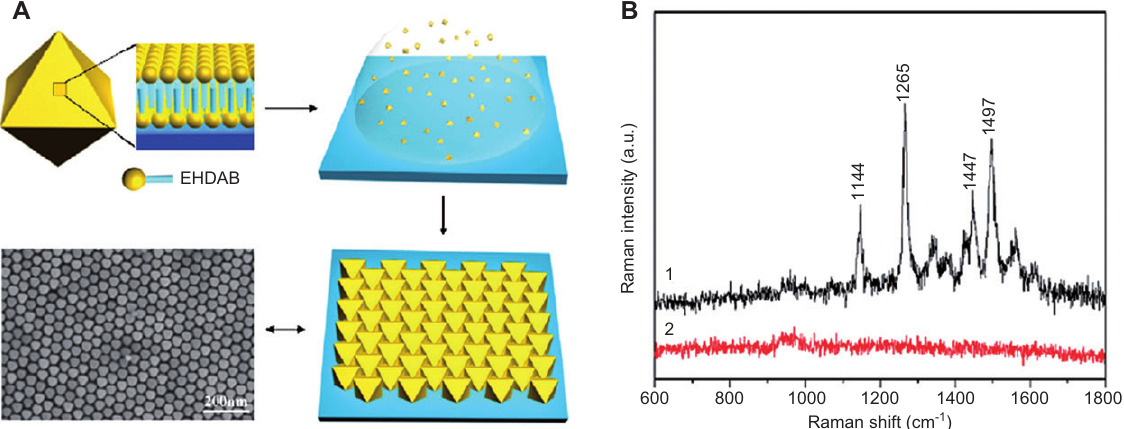
Figure 9 (A) Representation of the formation of ordered nanoparticle arrays. (B) SERS spectra of TNT (10 -8 m ). 1 – AuNPs coated with EHDAB, 2 – without EHDAB. Reproduced with permission from: Liu et al. (2011) . Copyright 2011,